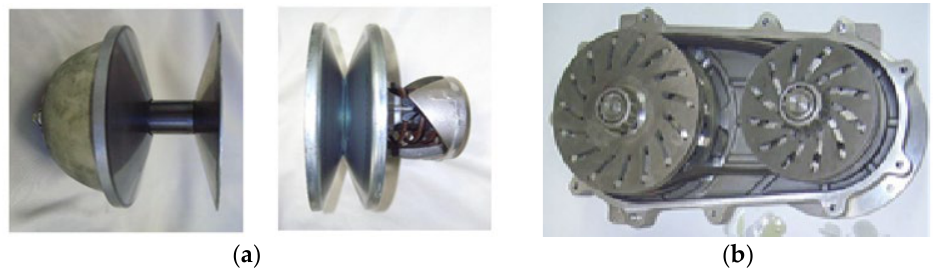
Figure 1. ( a ) CVT structure; ( b ) Centrifugal belt pulley CVT structure.